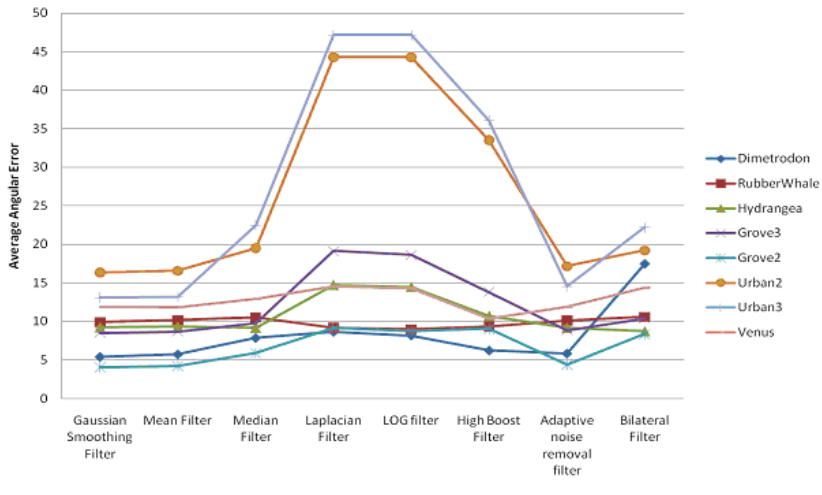
Figure 6. Average endpoint errors using different filters only on input images.